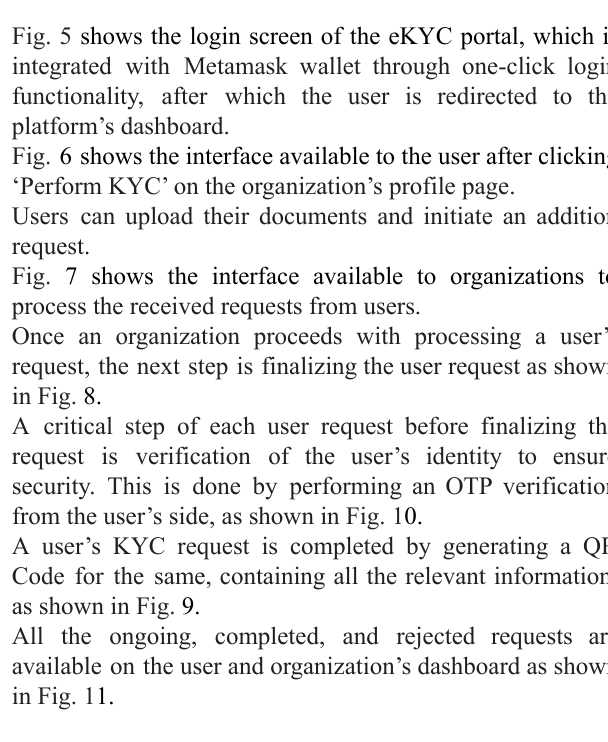
Fig. 11. User’s dashboard with all requests